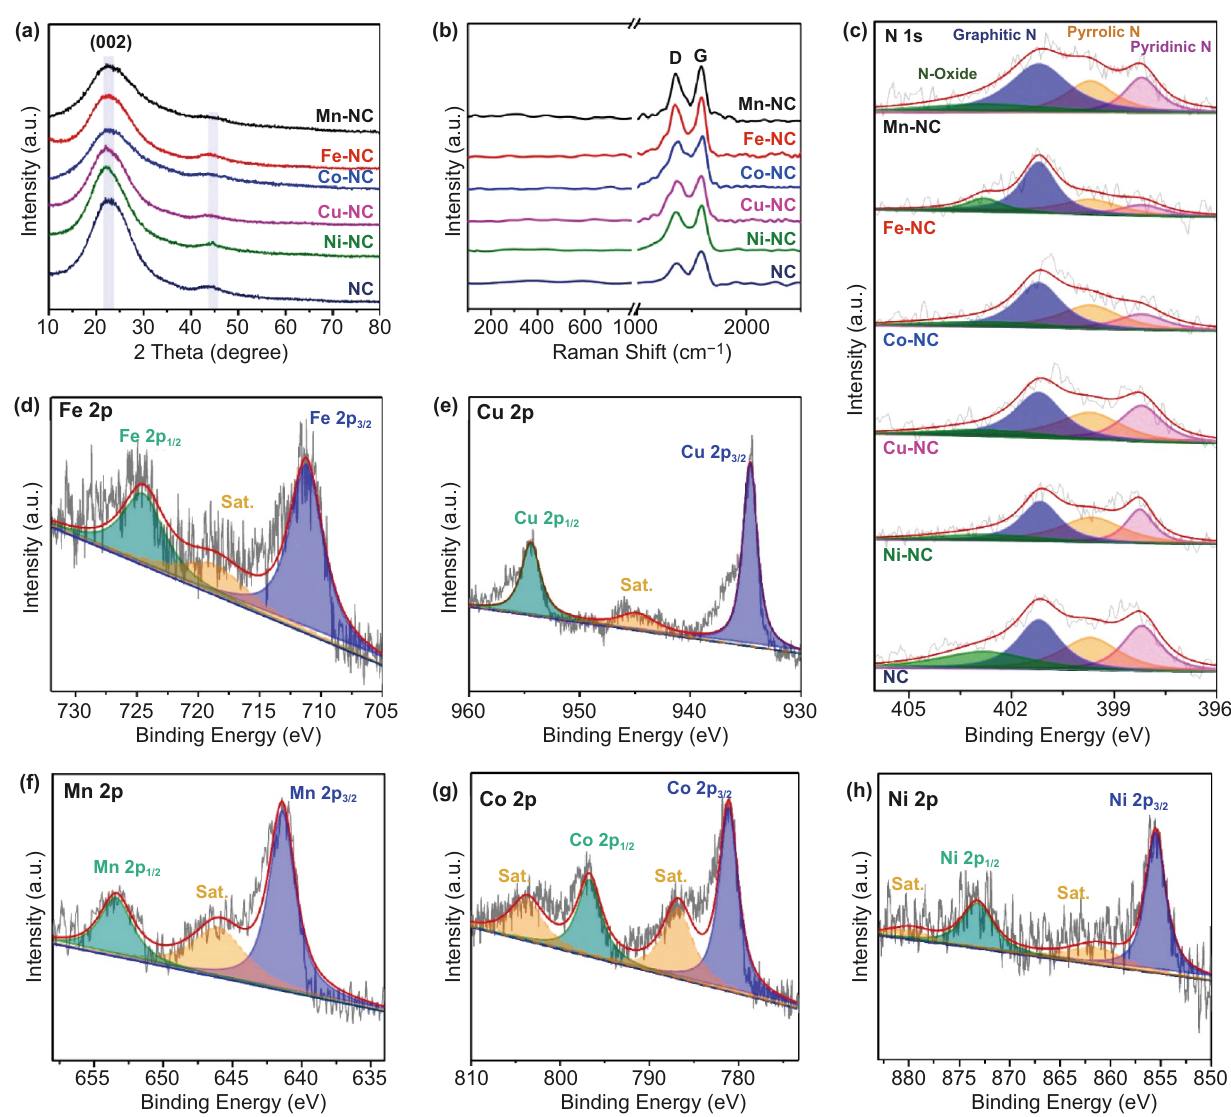
Fig. 3 a XRD patterns, b Raman spectra, and c high-resolution N 1 s spectra of the samples. Metal 2 p spectra of d Fe, e Cu, f Mn, g Co, and h